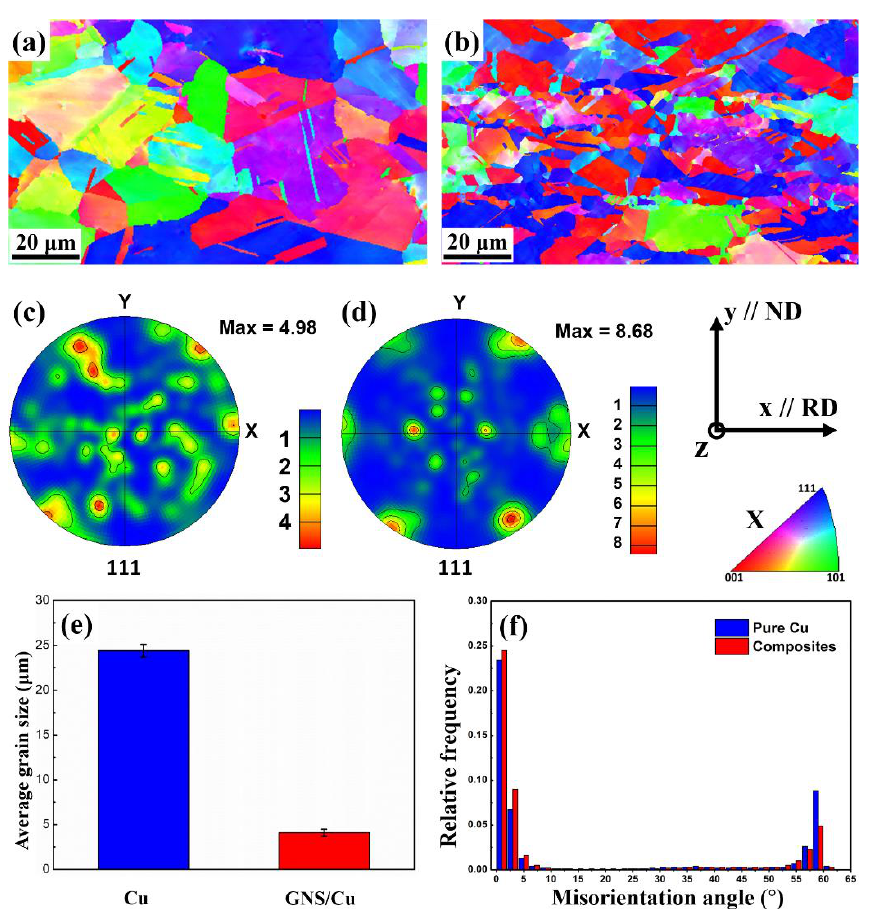
Figure 3. IPF-X images and {111} pole figures of hot-rolled ( a , c ) pure Cu and ( b , d ) GNS/Cu composites, and ( e ) average grain size and ( f ) misorientation angle distribution of hot-rolled pure Cu and GNS/Cu composites.